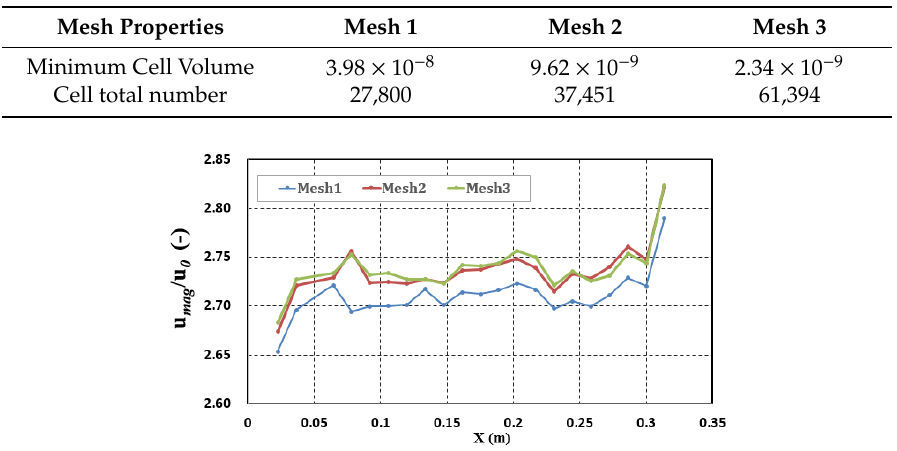
Table 1. The minimum cell volume and cell total number.